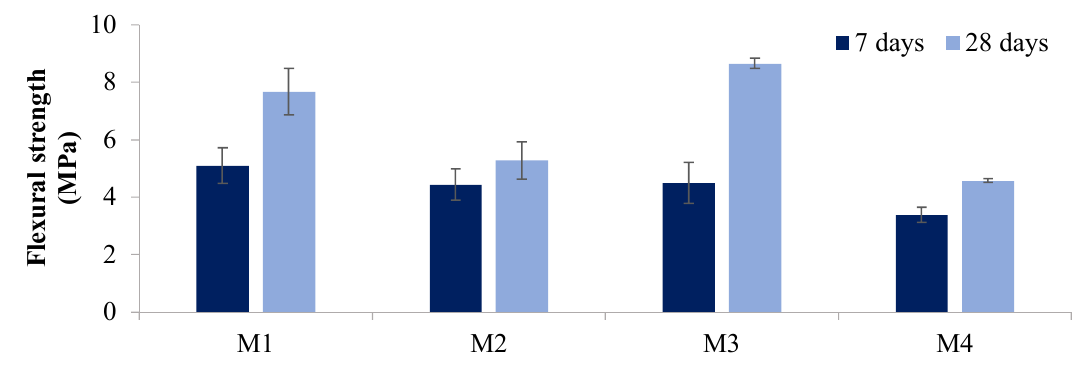
Figure 8. Flexural strength versus days at 20 °C.